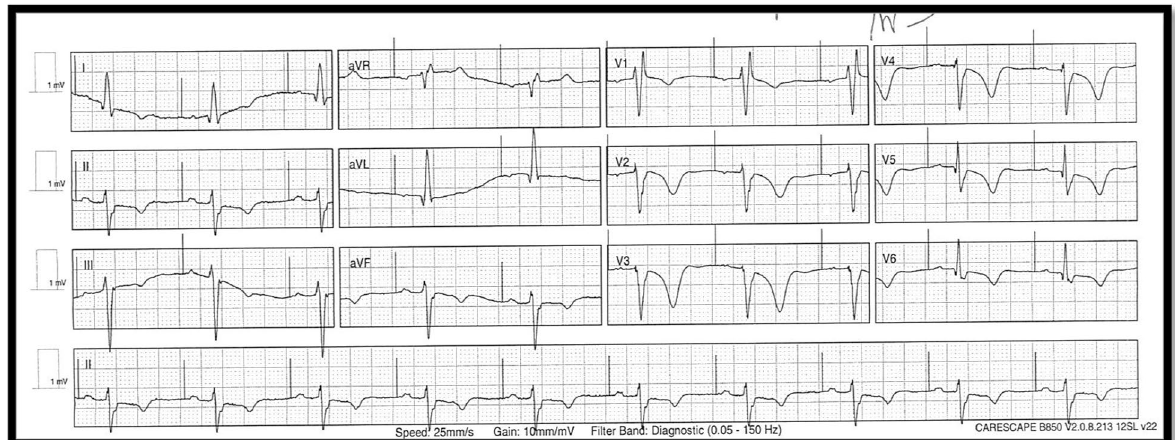
Fig. 1 ECG of Case 1 showing paced rhythm, LAD, incomplete RBBB and deep TWI anterolateral